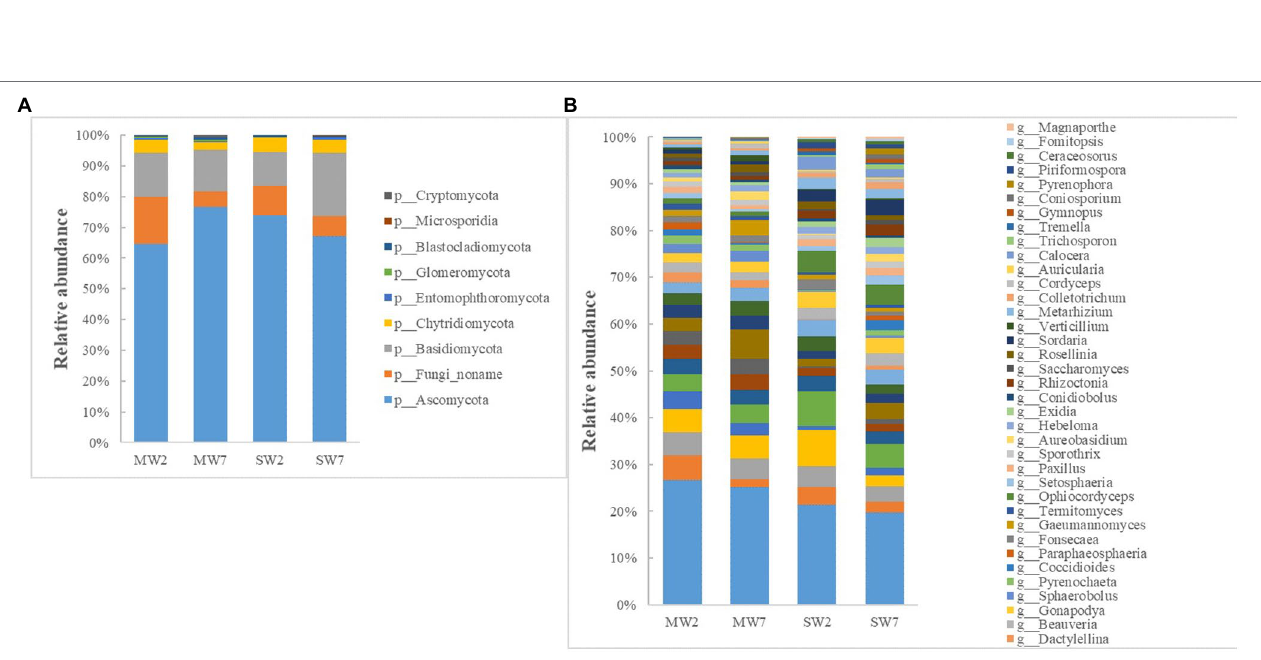
FIGURE 5 | The relative abundances of soil fungi community composition at phylum (A) and genus (B) level in the